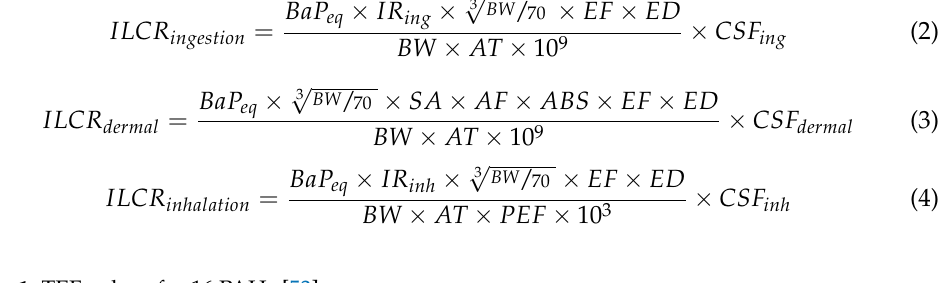
Table 1. TEF values for 16 PAHs